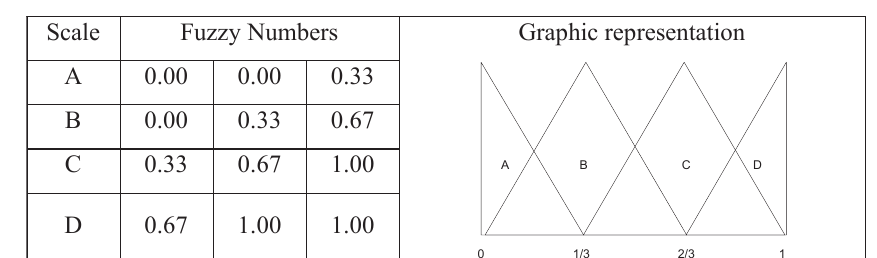
Table 2. Coding used to construct the dendrogram